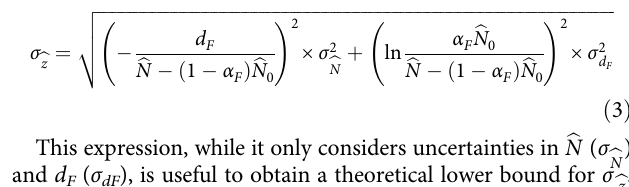
Fig. 1 Supercritical illumination microscopy enables photometric localization-enhanced z-resolution (SIMPLER). a Simpli fi ed optical layout of the excitation path of a TIRF microscope exemplifying isotropic emitters, which corresponds to the case of the dipolar emitter rotating faster than the measurement time. b Intensity of the excitation fi eld under TIR illumination for our experimental con fi guration: λ 0 = 642 nm, n i = 1.517, n s = 1.33 water, θ i = 69.5°, α = 0.9. c Simulated angular emission patterns of a dipolar emitter oriented either perpendicular (up) or parallel (bottom) to the water – glass interface and located at 5, 50, 150 and 250 nm above it. These calculations are made for λ 0 = 670, the maximum emission wavelength of the fl uorophores. d Fraction of fl uorescence signal collected (CF collected fl uorescence) with the microscope objective (NA = 1.42) for a fl uorophore emitting at 670 nm and oriented parallel (blue dotted line) or perpendicular (green dotted line) to the glass/water interface, normalized to the case of a molecule far from the interface. The solid red line represents the isotropic average corresponding to the case of a rotating fl uorophore. e Calculated z -dependent fl uorescence signal (represented in logarithmic scale) of single molecules expressed as the ratio of number of photons detected at a given z -position ( N ) and the number of photons of an identical emitter placed at z = 0 ( N 0 ). Principle of SIMPLER: the axial position of single molecules is retrieved from N / N 0 either through the exact solution ( I ( z ) × CF avg ( z ), solid red line) or through its exponential approximation (solid blue line — Eq. (2)). f Calculated images of single molecules at z = 5, 50, 150 and 250 nm with normalized intensity; xy images at the focal plane (right) and pro fi les along x (left). g Theoretical lower bound for the axial localization precision of SIMPLER (Eq. (3)) for different sets of N 0 and σ dF with d F = 87.5 nm and α F = 0.93. Comparison of the theoretical localization precision of SIMPLER with respect to the reported precision of two other well-established z -localization techniques: single lens astigmatism and DONALD, for ^ N 0 = 7000 photons (data taken from 10